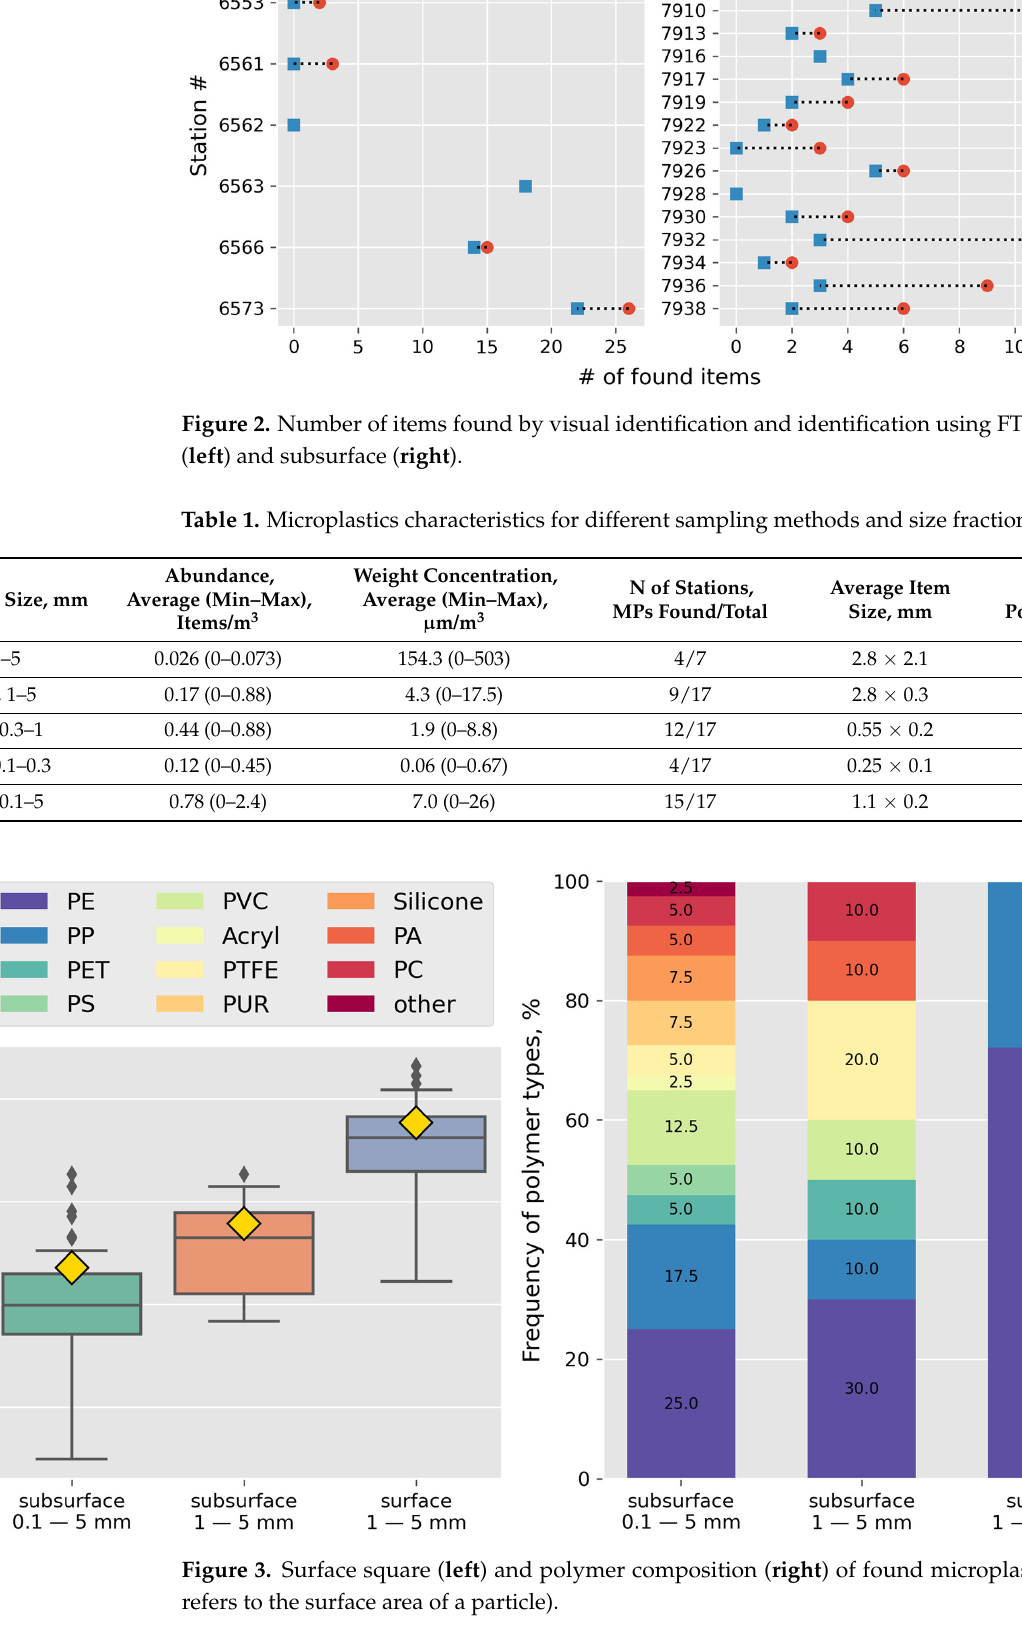
MPs in one transect). Three stations, 6561, 6562, and 6563 in the equatorial Atlantic (10°